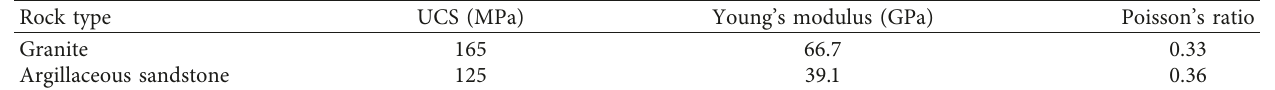
Table 1: Mechanical properties of the granite and argillaceous sandstone.